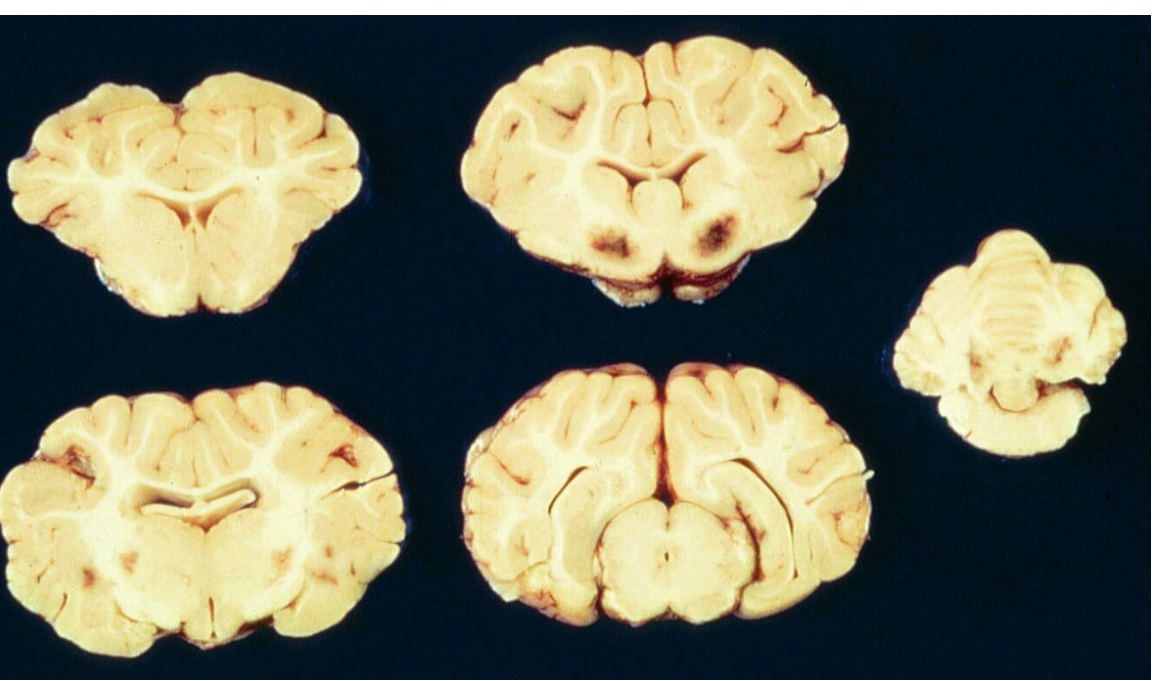
Figure 5. Focal symmetrical encephalomalacia (FSE) in a sheep showing bilaterally symmetrical necrotic foci in the corpus striatum, thalamus and cerebellar peduncles. Photo courtesy of B. Hartley.